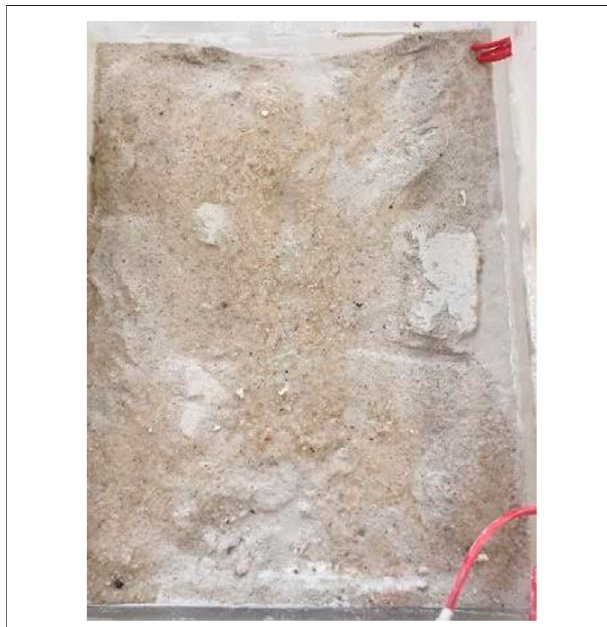
FIGURE 8 | Excitation of water-rich surrounding rock of sandy